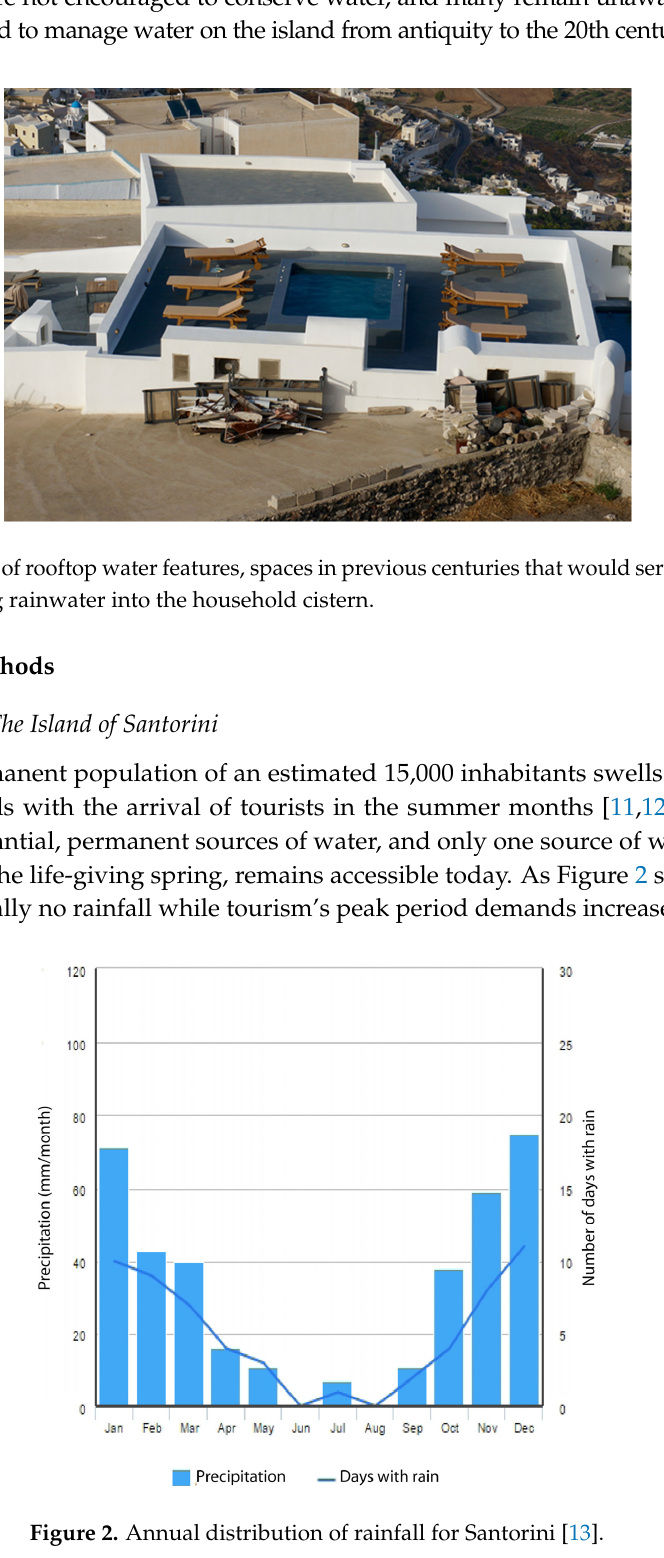
Figure 2. Annual distribution of rainfall for Santorini [13].